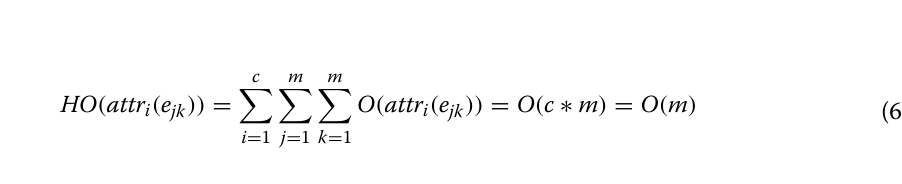
Maximizing degree of nodes